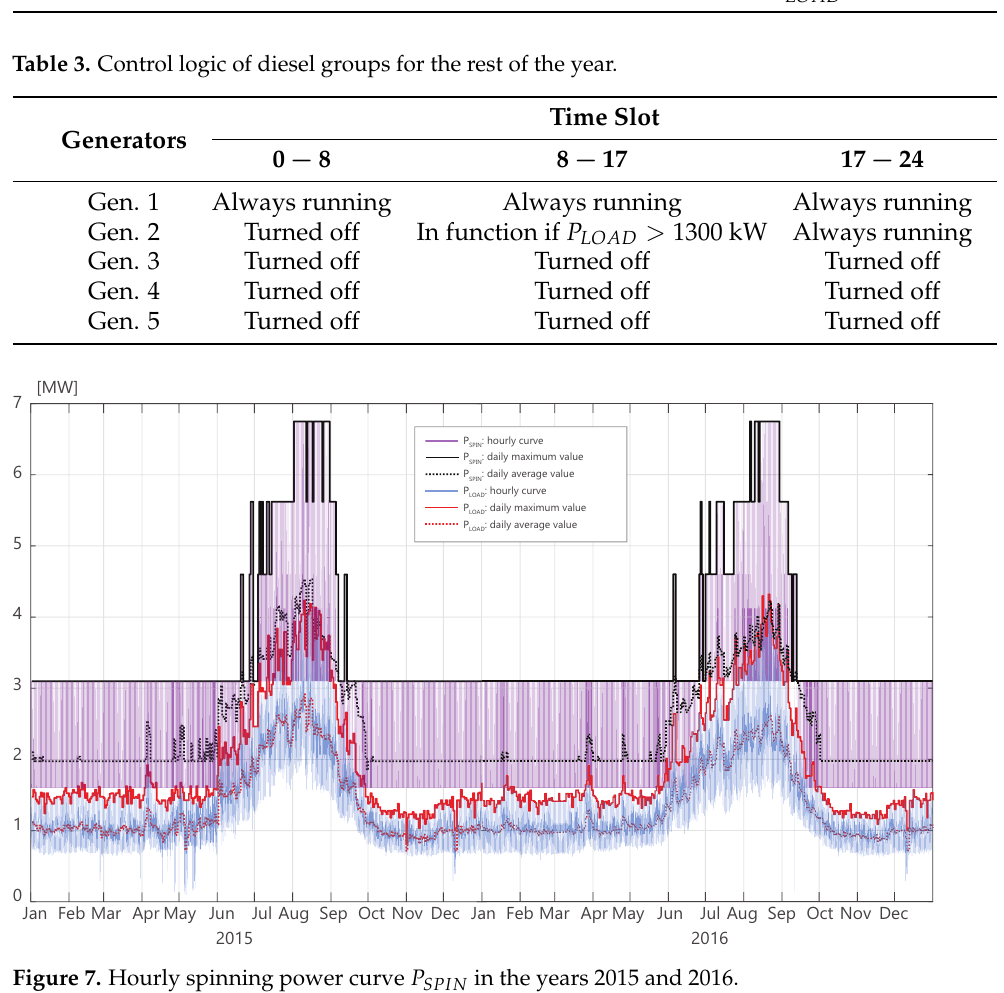
Figure 7. Hourly spinning power curve P SPIN in the years 2015 and